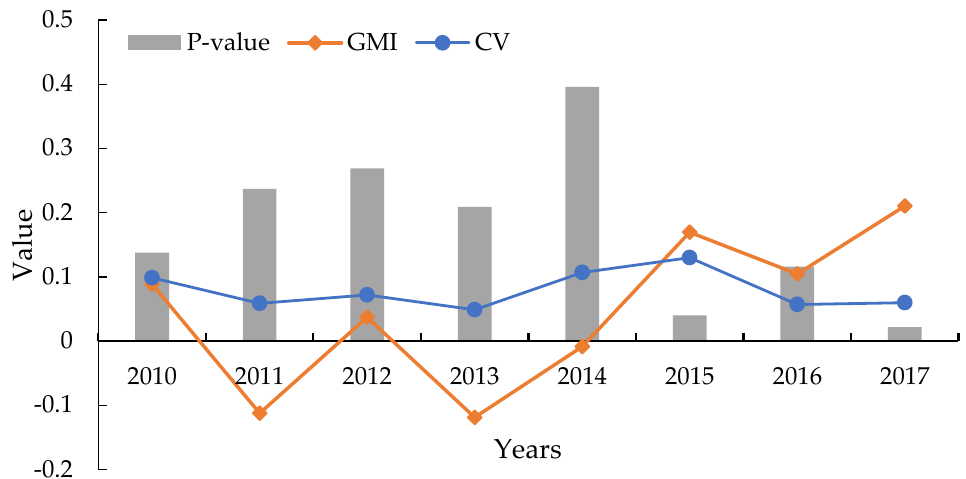
Figure 4. The trend in the changes in overall sustainable performance and in the coefficient of variation. The Moran scatterplots of the scores for the SPCI in the 30 provinces in 2015, 2016 and 2017 are shown in Figure 5. The four quadrants in a Moran scatterplot are used to identify the relationship between an area and its expected neighbors. Thus, these figures in Figure 5 depict the local spatial autocorrelation. The provinces in the first quadrant (H-H) not only have high SPCI values, but also their neighboring provinces have high SPCI values. The provinces in the second quadrant (L-H) have low SPCI values, but their neighboring provinces have high SPCI values. The provinces in the third quadrant (L-L) have high SPCI values, but their neighboring provinces’ SPCI values are low. The provinces in the fourth quadrant (H-L) have high SPCI values, but are surrounded by provinces with low SPCI values. The number of provinces in the H-H category was only 4 in 2015 and increased to 11 in 2018, together with a trend toward fewer provinces being distributed in the L-H or H-L categories. This trend suggests a decrease in the disparity in SPCI between provinces and their neighbors. In conjunction with the Moran scatterplots, the local spatial category maps are shown in Figure 5. The H-H category appears predominantly in the east, while the L-L category generally appears in the west. Additionally, the SPCI can be seen to improve from east to west, especially in southern China. This phenomenon shows that the SPCI of each province has obvious clustering characteristics and the provinces with high SPCI values are often concentrated in the eastern region. In contrast, the provinces with low SPCI values are concentrated in the western